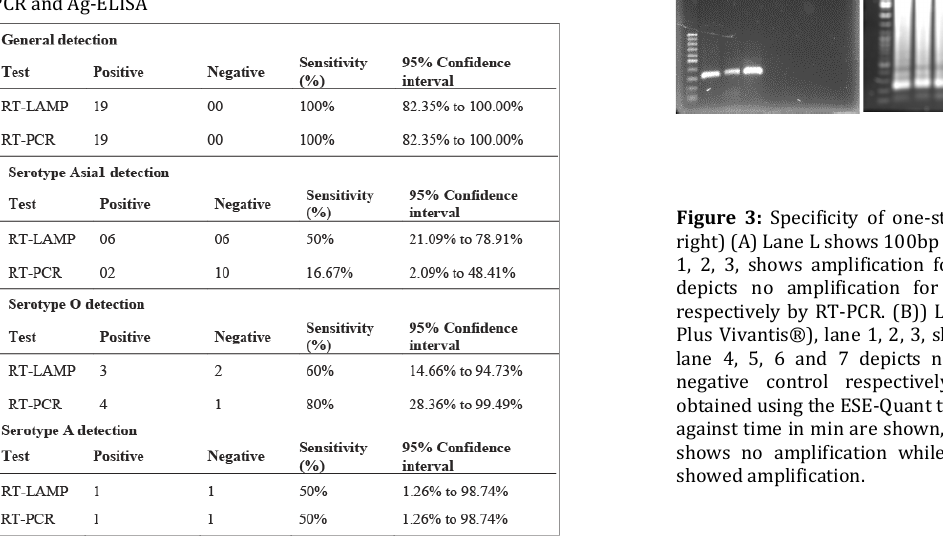
Primer sets were found specific for FMDV when subjected to RNA templates of other viruses such as Infectious barsal disease virus (IBDV), New castle disease virus (NDV) and Peste Des Petites Ruminants virus (PPRV)in both RT-PCR and RT-LAMP assays (figure 3). Results of typing primers revealed that all the primers are type specific and showed no cross-reactivity for other serotypes in both RT-PCR and RT-LAMP techniques. A